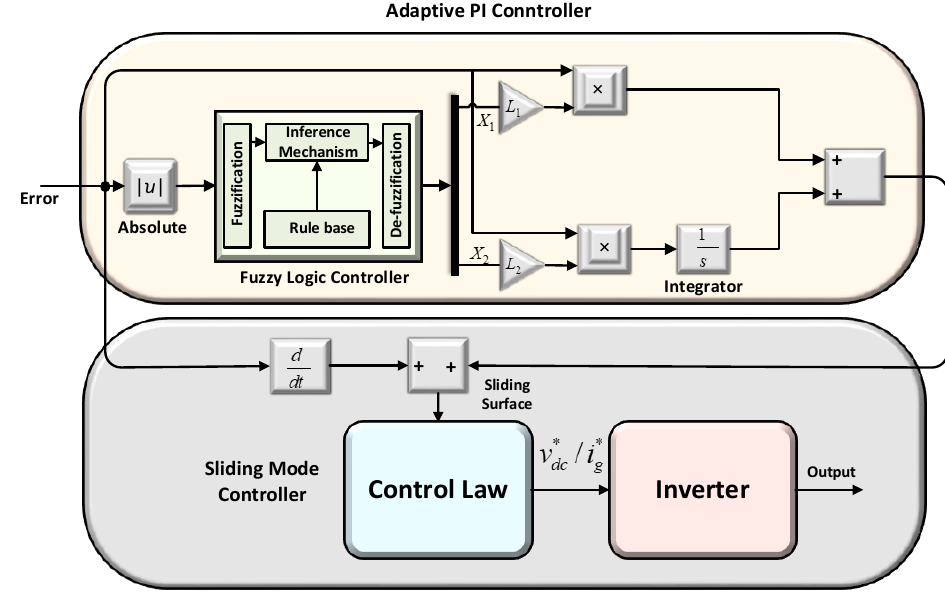
Figure 8. The Fuzzy-Sliding Mode Controller.